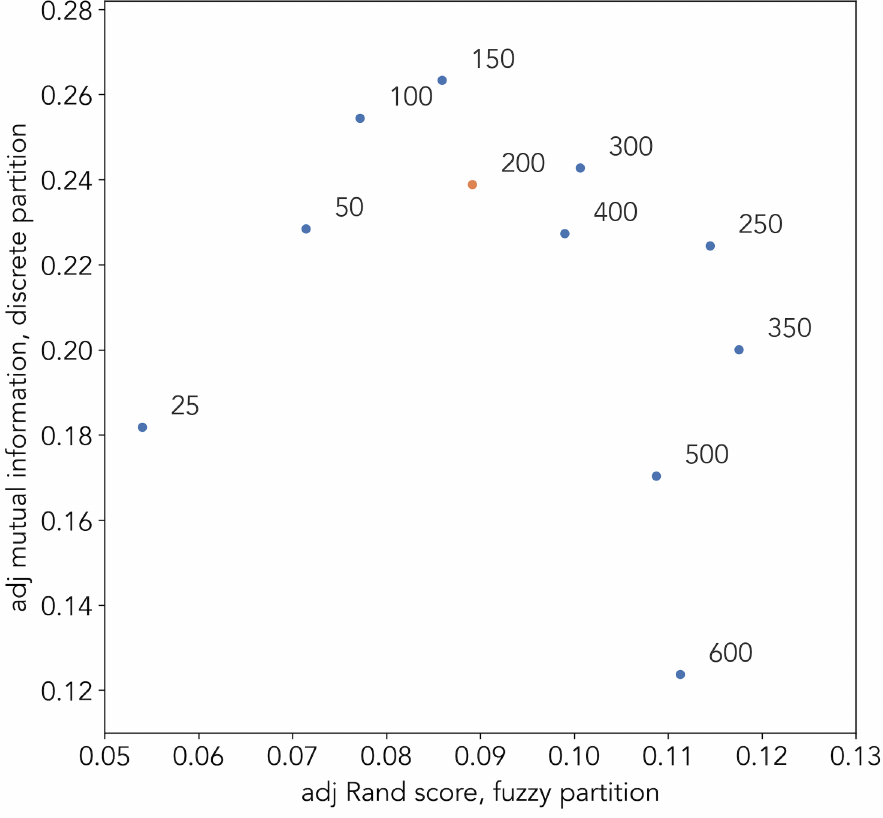
Figure 6: Strength of alignment between topic models and a partitioning of the same volumes in human ground truth. Both “adjusted mutual information” and “adjusted Rand score” are higher when volumes in the same human category are also characterized similarly by the